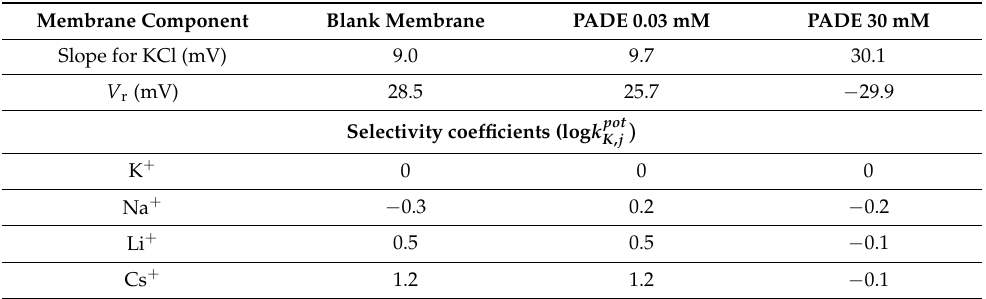
Table 4. The slope for KCl, reference potential ( V r ), and selectivity coefficients of the sensors.